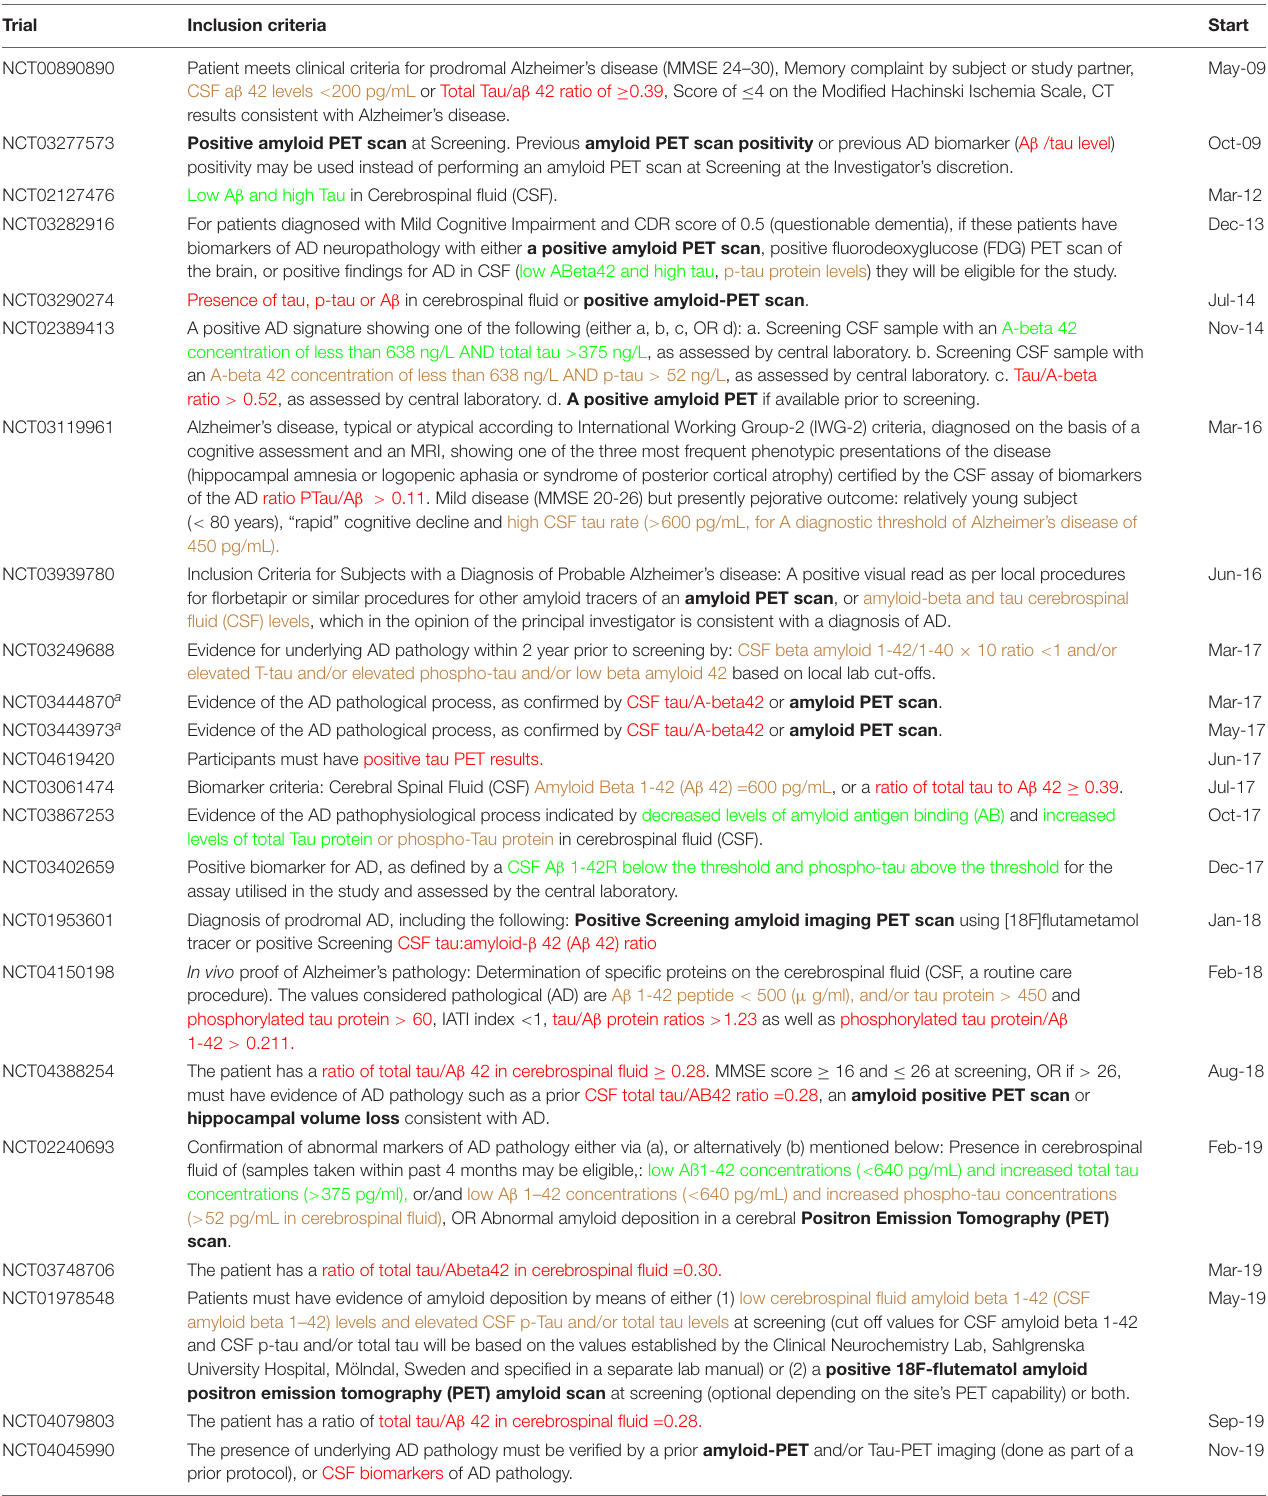
TABLE 2 | Use of CSF biomarkers for enrichment of clinical trials in AD. Trial Inclusion